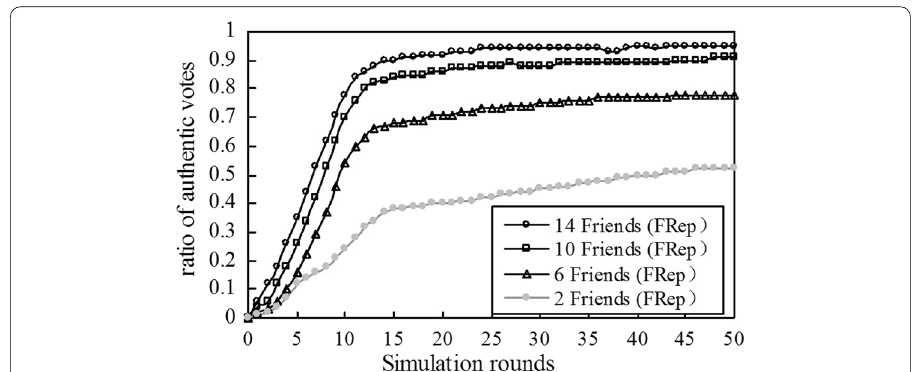
Fig. 9 Simulation result of different friends number. A trust network based on community relationships plays an important role in FRep performance. Through simulation experiments, we analyzed the influence of network connectivity, that is, the number of online friends of each node on FRep performance. The experimental environment is still the collusion attack scenario. The collusion nodes account for 10% of the total number of nodes, and the number of friends is set as 14, 10, 6 and 2,